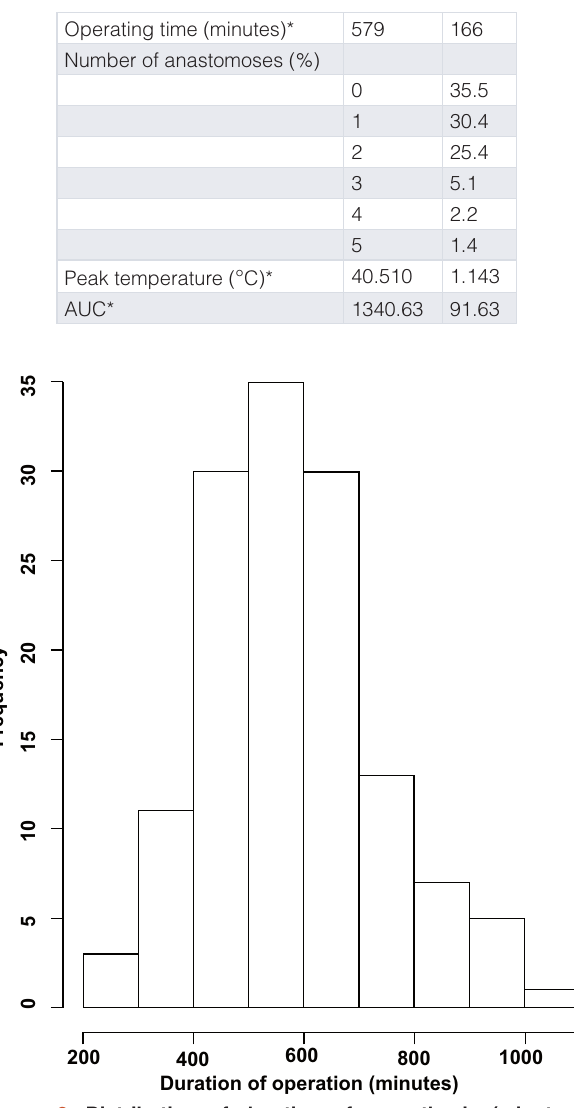
Table 2.le 2. Details of surgery (Mean and Standard